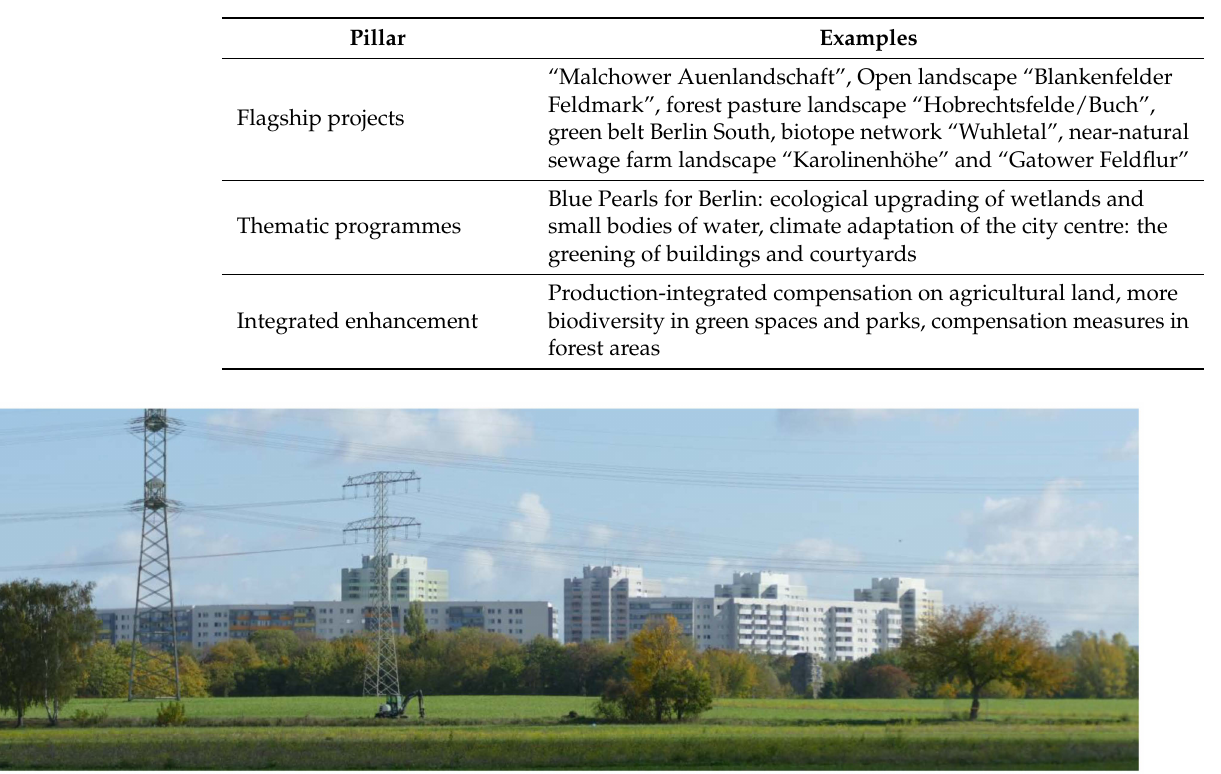
Figure 1. Areas dedicated to land-use planning eco-accounts (LUP-EAs) by Berlin Senate resolution and one nature conservation law eco-account (NCL-EA) approved by the upper nature conservation authority of Berlin; status December 2022 (to be published in Berlin Geoportal). Table 2. Strategic pillars of the overall urban compensation concept, adopted from [43] (p. 16).